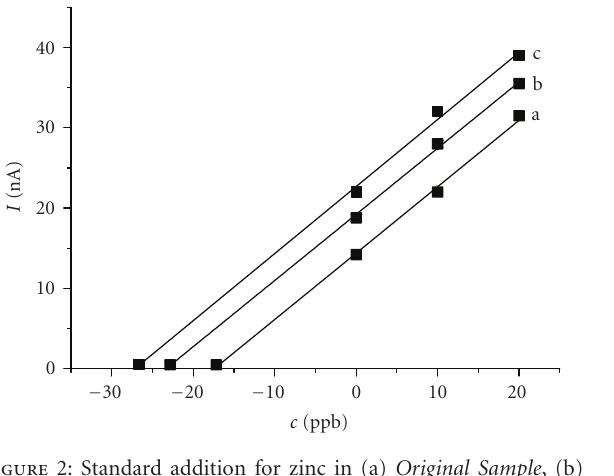
Figure 2: Standard addition for zinc in (a) Original Sample , (b) SoUV Sample, and (c) UV Sample.